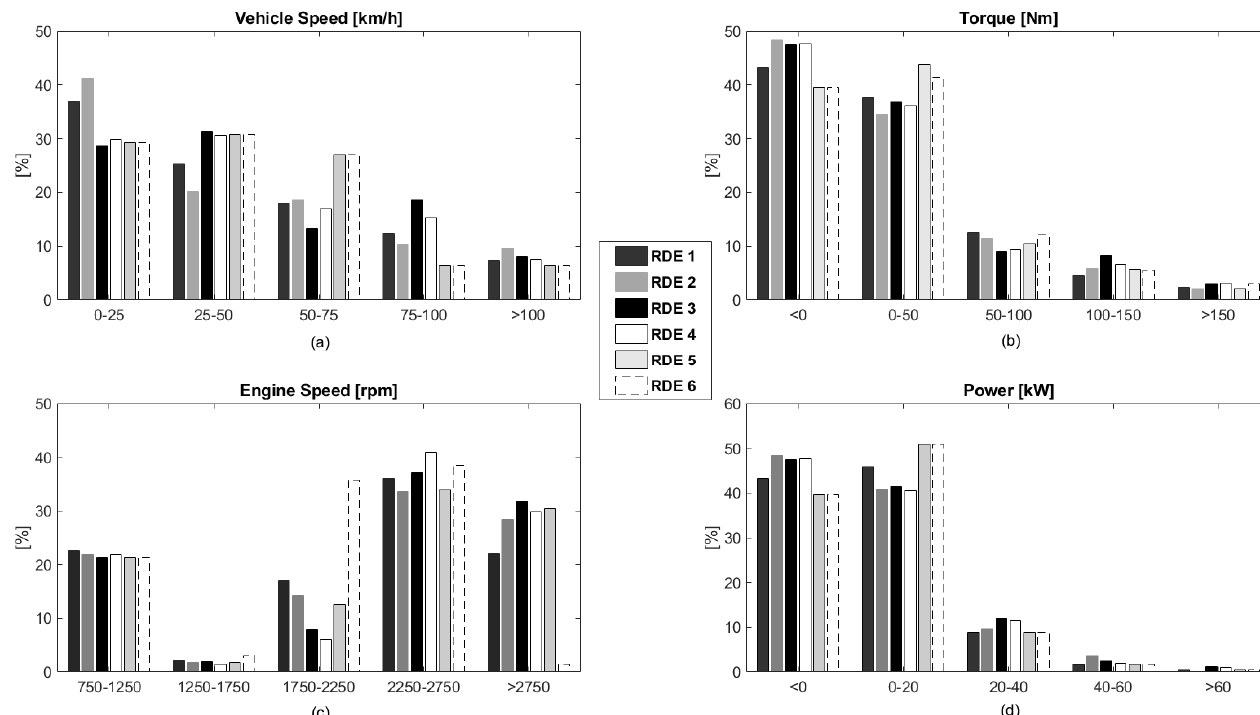
Figure 5. Distribution of ( a ) vehicle velocity, ( b ) torque, ( c ) engine speed, and ( d ) power.